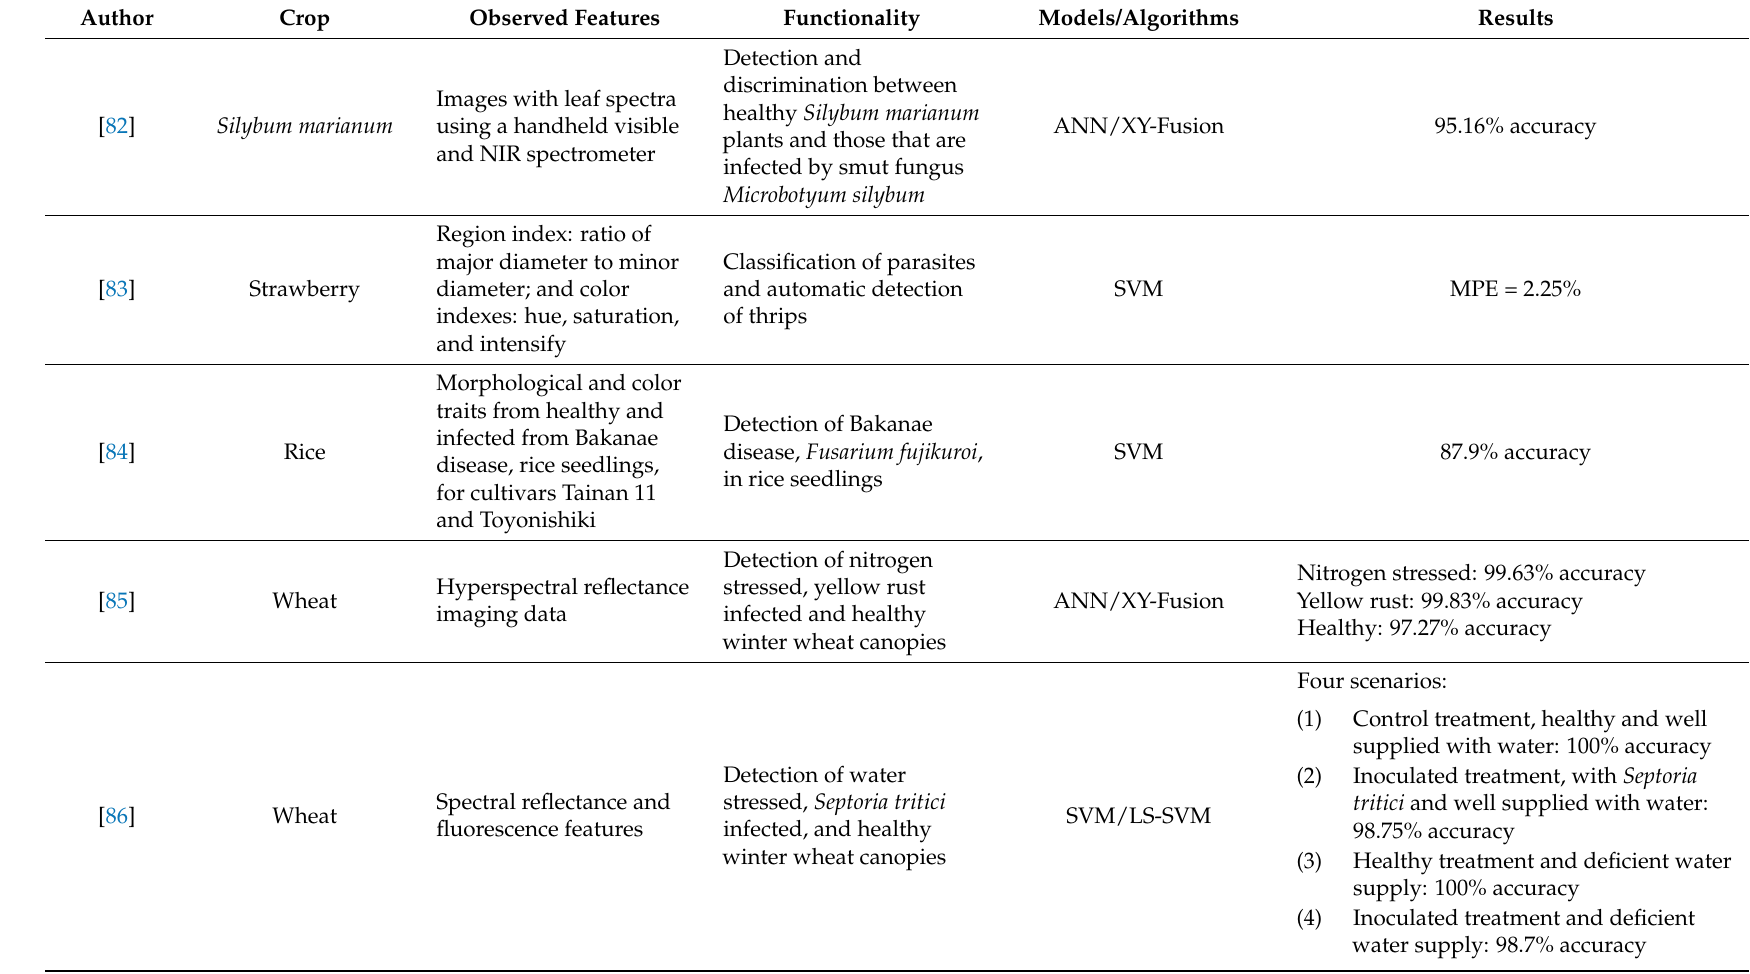
Table 6. Crop: disease detection